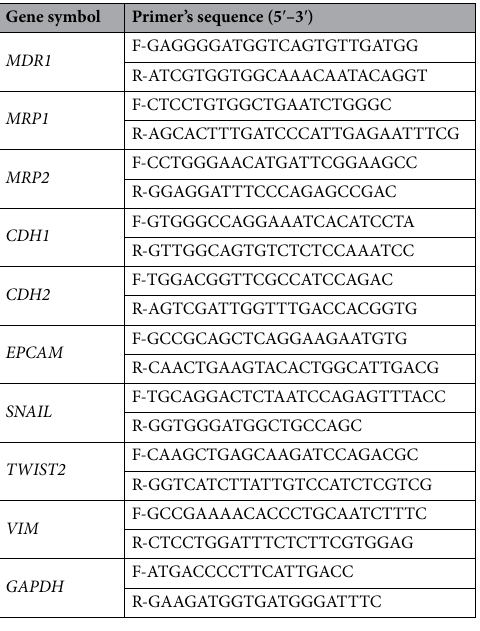
Table 1. Primer sequences used for quantitative real-time PCR in this